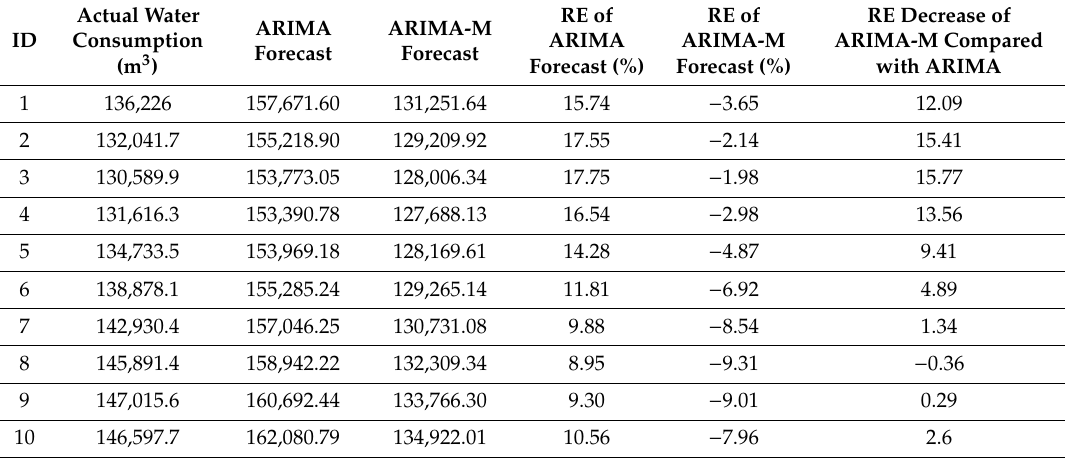
Table 9. Forecast value of monitoring point 1 during the following 10